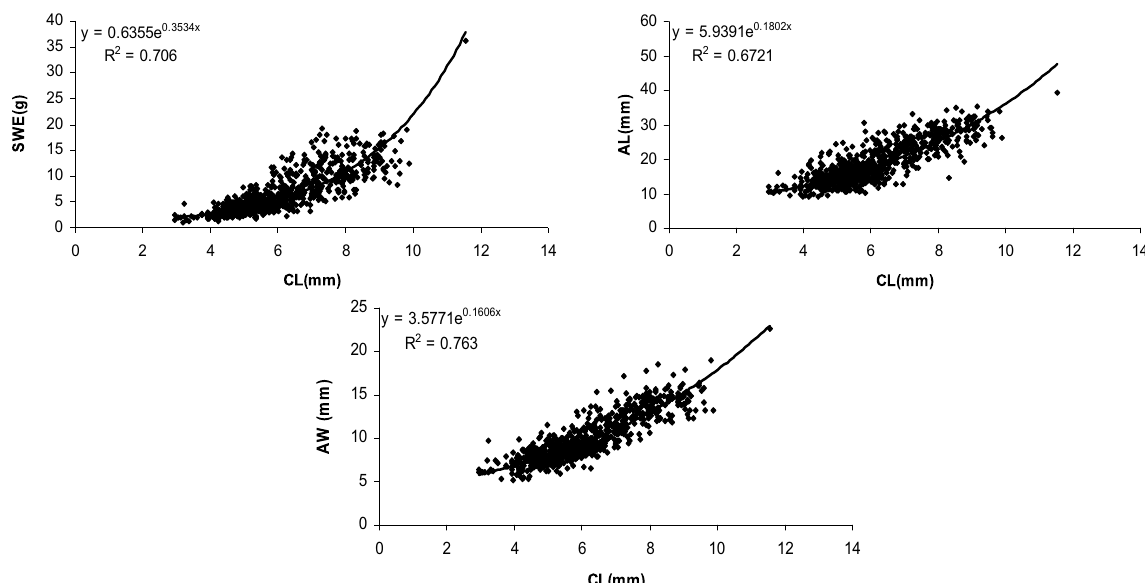
CL = cephalothoracic shield length; SWE = shell weight; SL = shell length; SW = shell weight; AL=aperturelength; AW=aperturewidth; r=correlationindicesofSpearman.